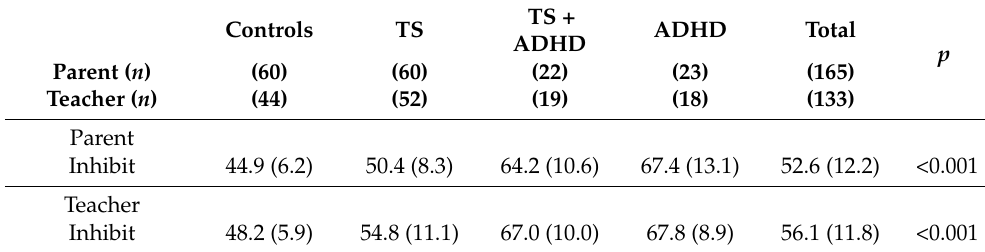
Table 3. Group differences in the BRIEF-Inhibit scale.